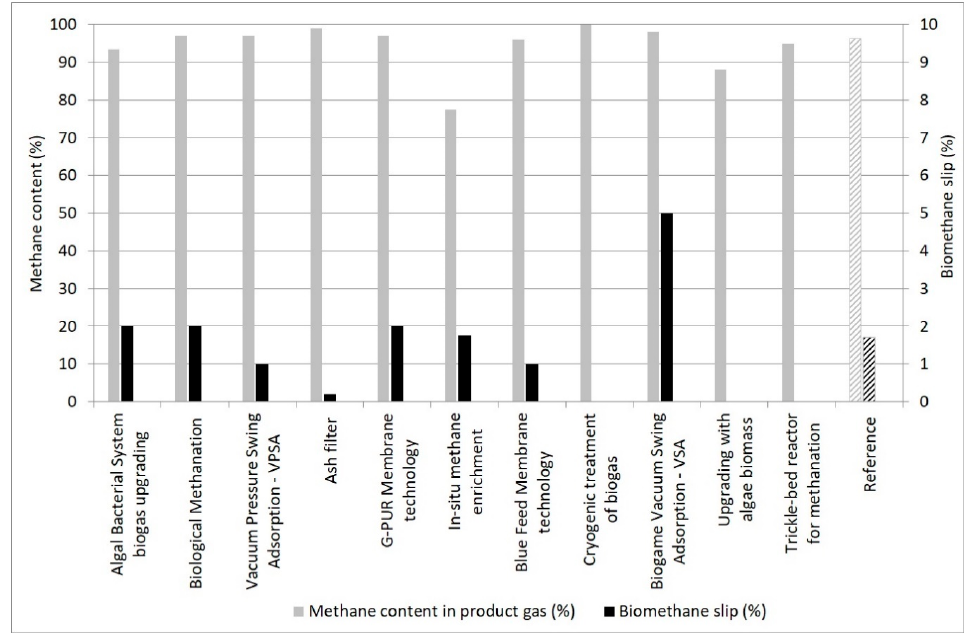
Figure 5. Methane content of biomethane and biomethane slip for upgrading technologies.